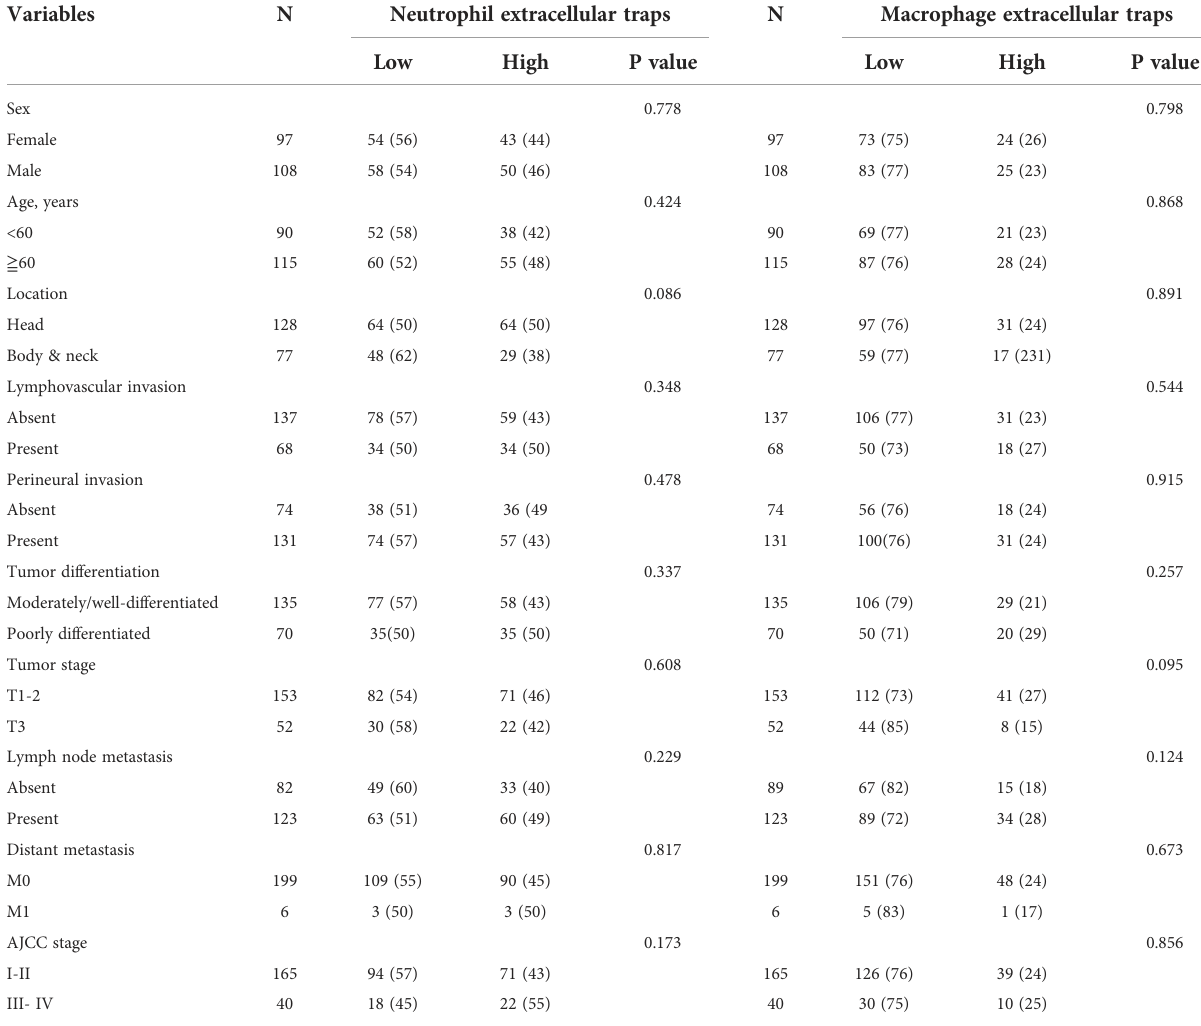
TABLE 1 Associations between neutrophil or macrophage extracellular traps and clinicopathological features.